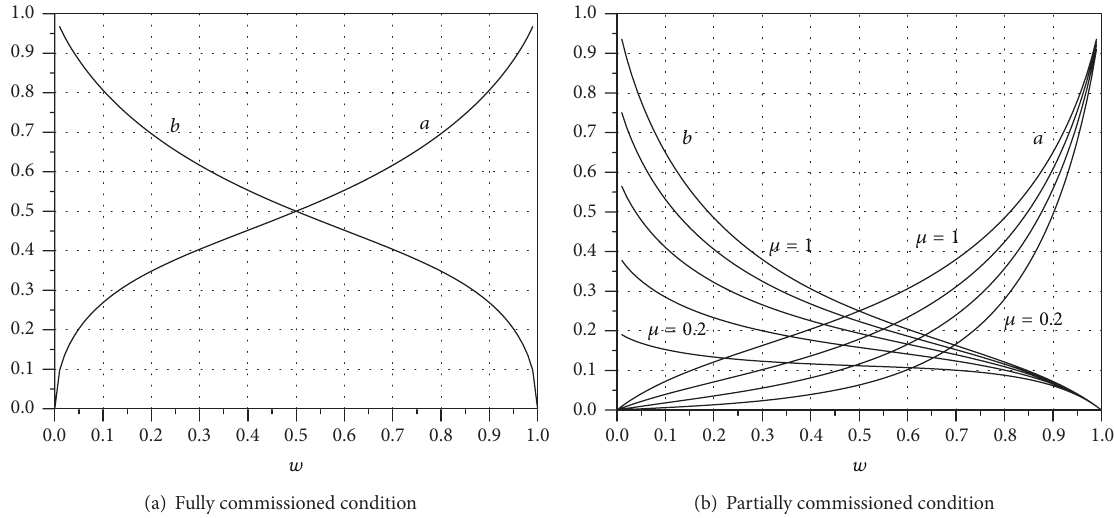
Figure 4: Effort level for the owner and contractor under different knowledge division.